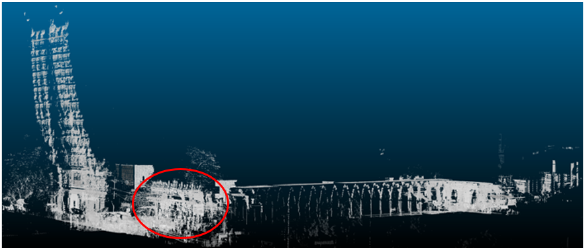
Figure 3 . West front of the Puthu Mandapum. [Pudu Mandapa,